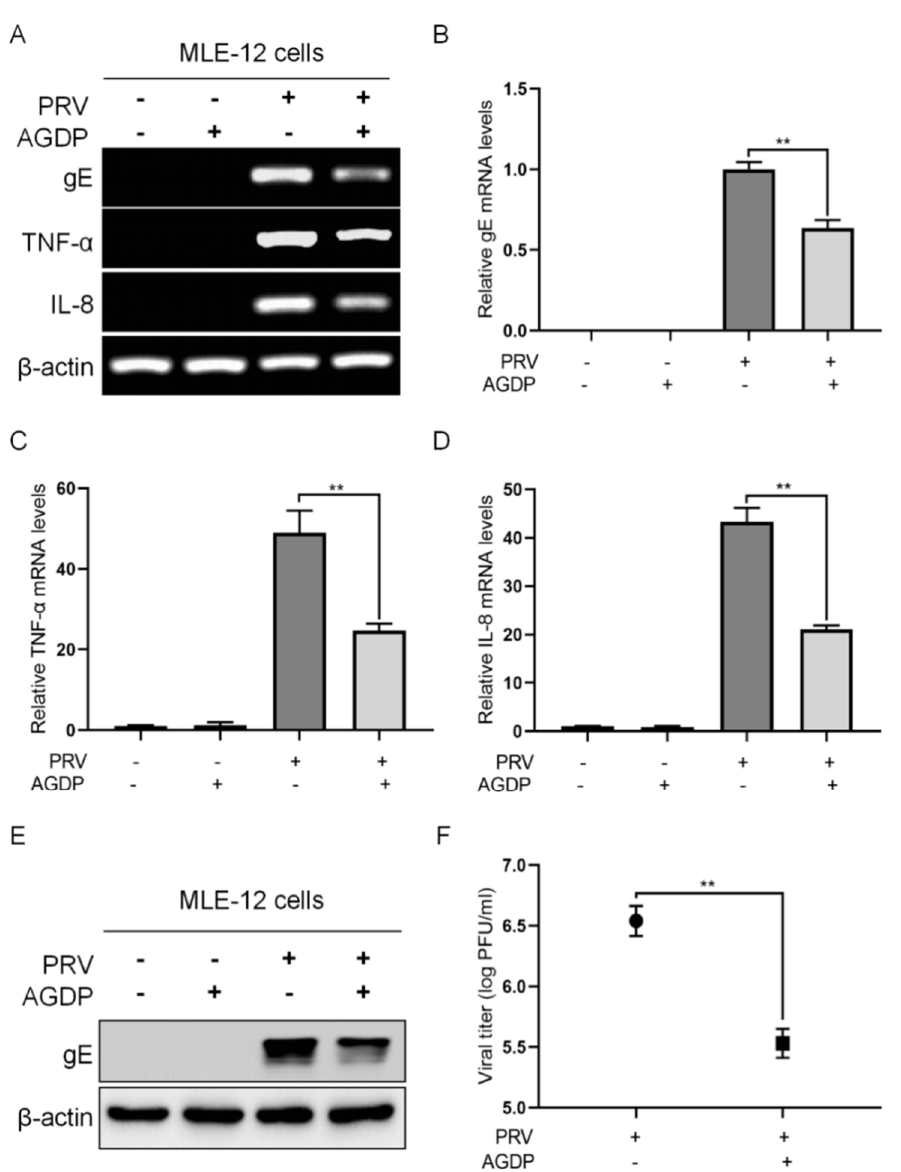
Figure 7. AGDP exerted anti − PRV infection properties in MLE − 12 cells at 24 hpi. ( A ) RT − PCR detected the expression of TNF − α and IL − 8 mRNAs, and PCR analyzed the expression of gE in responding to PRV infection; ( B – D ) qRT − PCR detected the expression of TNF − α and IL − 8 mRNAs, and qPCR analyzed the expression of gE in responding to PRV infection; ( E ) The expression level of PRV gE protein in MLE − 12 cells were measured by WB; ( F ) The virus titer was detected by plaque assay. β− actin was used as a reference gene for internal standardization. ** p < 0.01.